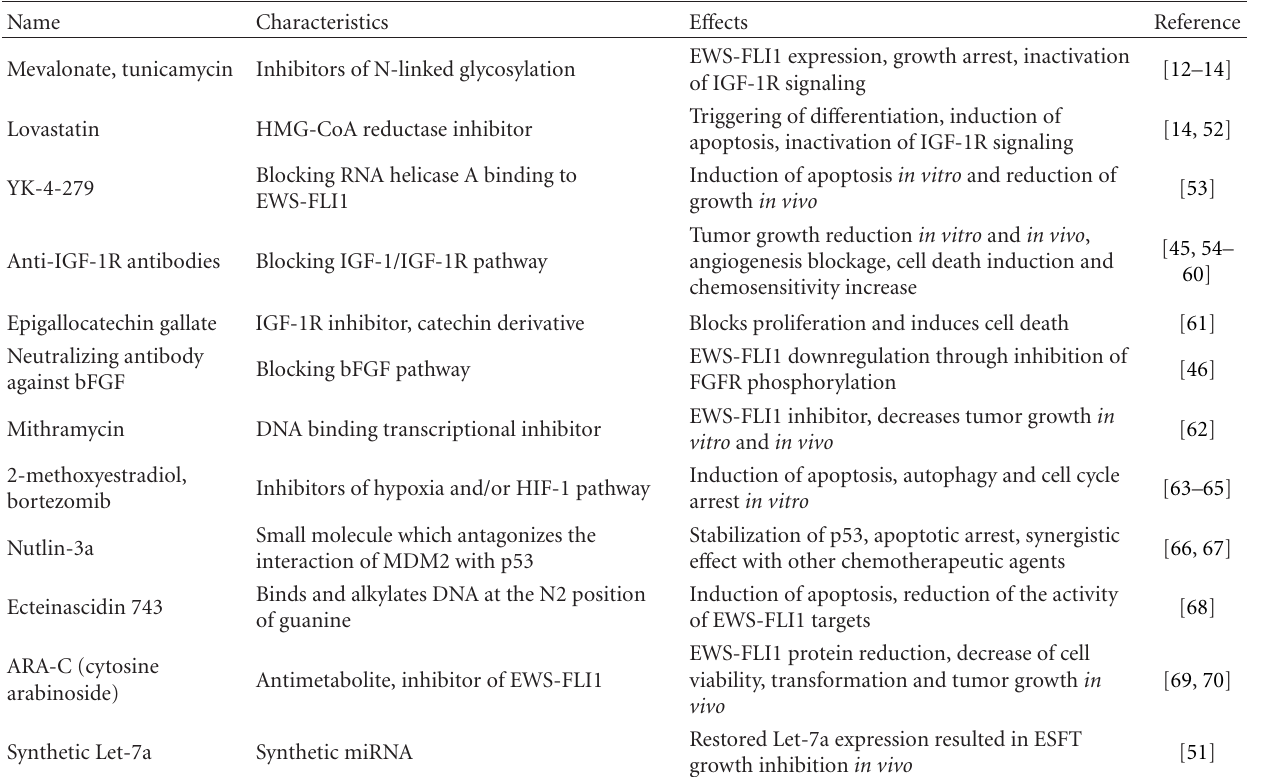
Table 2: Therapeutic agents targeting partners essential for